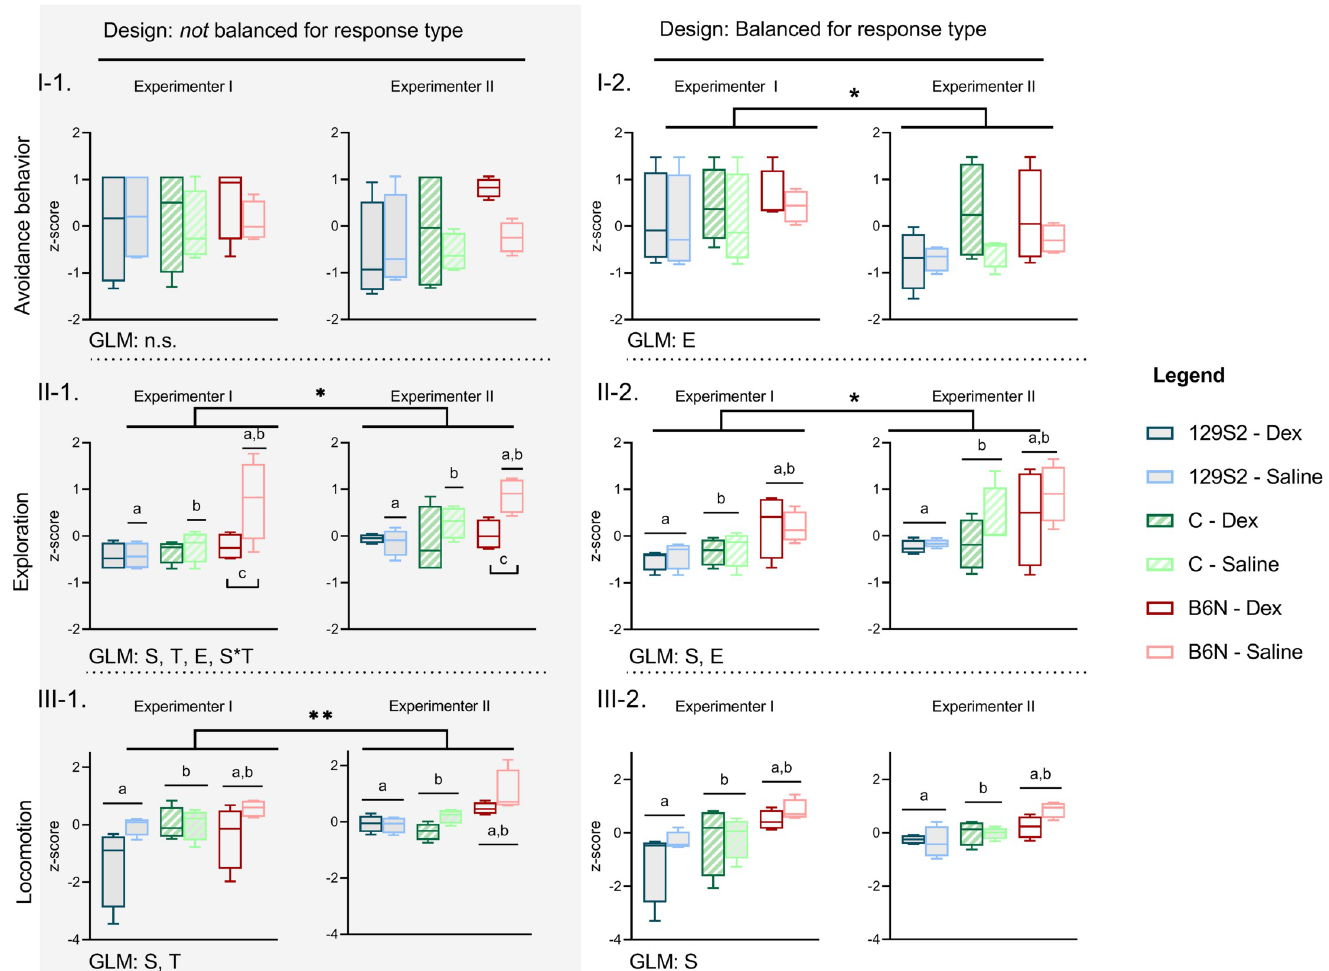
Fig 6. Behavioral scores of a pool of mice not balanced for individual response type (left), and a pool balanced for individual response type (right). (I-III) Results expressed as integrated behavioral z-scores and presented as boxplots (median, upper and lower quartiles) with Tukey whiskers. Effects significant in GLMs at P < 0.05, where � = 0.01 � P < 0.05, �� = 0.001 � P < 0.01. T: Significant effect treatment; S: Significant effect strain; S � T: Significant interaction between treatment and strain; E: Significant effect experimenter; n.s. = no significant difference. Significant post hoc comparisons indicated with a lower-case letter, where (II-1) the same lower-case letter above two single boxplots indicates a significant post hoc comparison between strains for one treatment condition only and (II-2, III-1, III-2) the same lower-case letter above combined boxplots indicates a significant post hoc comparison between strains regardless of treatment ( P -value adjusted for multiple comparisons, S2 Table). The raw integrated z-scores (mean ± 95% CI) of each group depicted in this figure are presented in S7 Table.